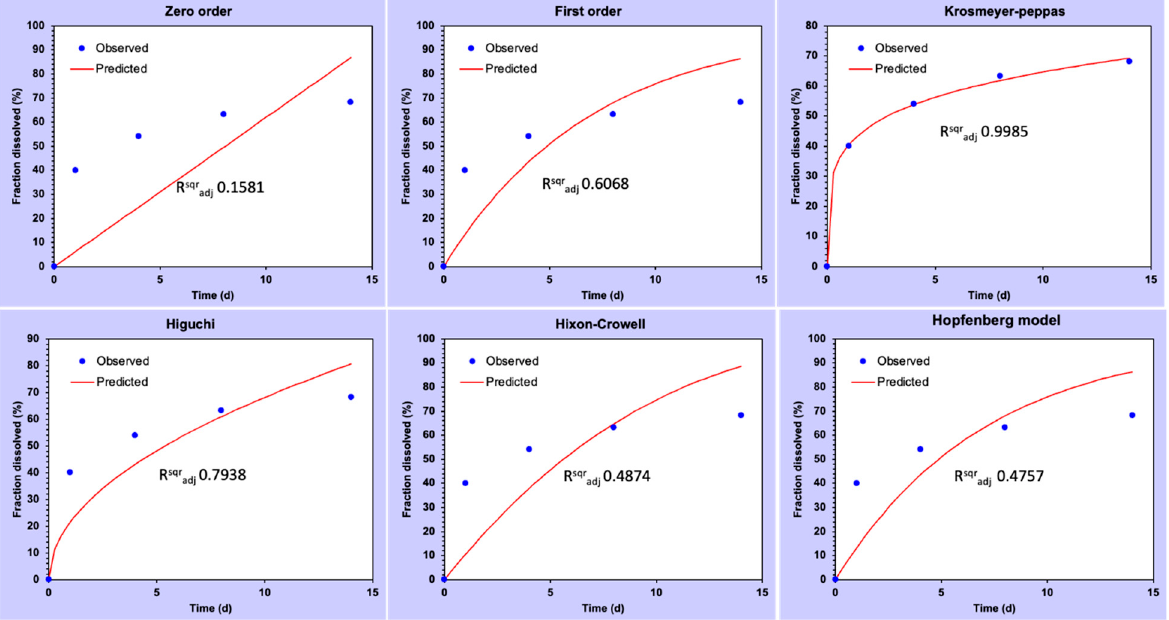
Figure 4. Graphs showing different drug release kinetic models for pSi-TC nanoparticles during the 14 days.